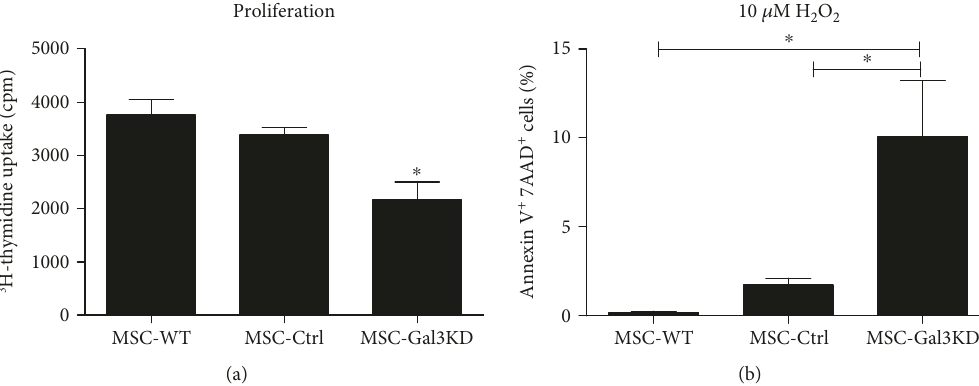
Figure 3: E ff ects of Gal-3 knockdown on cell proliferation and survival. (a) Proliferation rate in di ff erent MSC lines, evaluated by 3 H-thymidine incorporation assay. ∗ P < 0 05 , compared to the other groups. (b) Apoptosis analysis by Annexin V/7-AAD assay, comparing the rate of cells undergoing apoptosis after incubation with 10 μ M H nontargeting shRNA vector; MSC-Gal3KD=Gal-3 knockdown MSC. ∗ P < 0 05